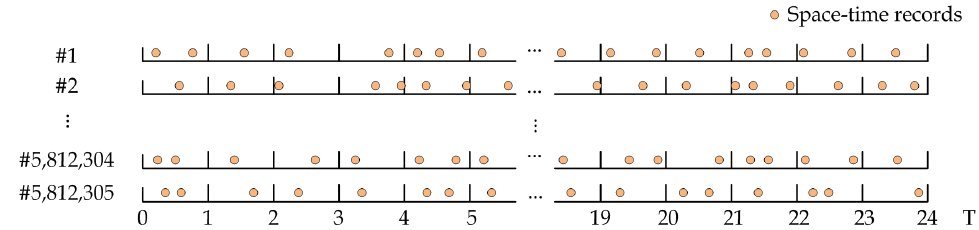
Figure 5. Dividing each subscriber’s records into 24 time segments.